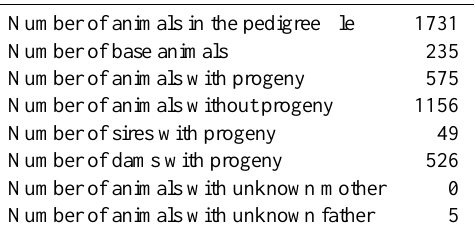
Table 1. Pedigree structure of the Afshari sheep. Number of animals in the pedigree file 1731 Number of base animals 235 Number of animals with progeny 575 Number of animals without progeny 1156 Number of sires with progeny Number of dams with progeny